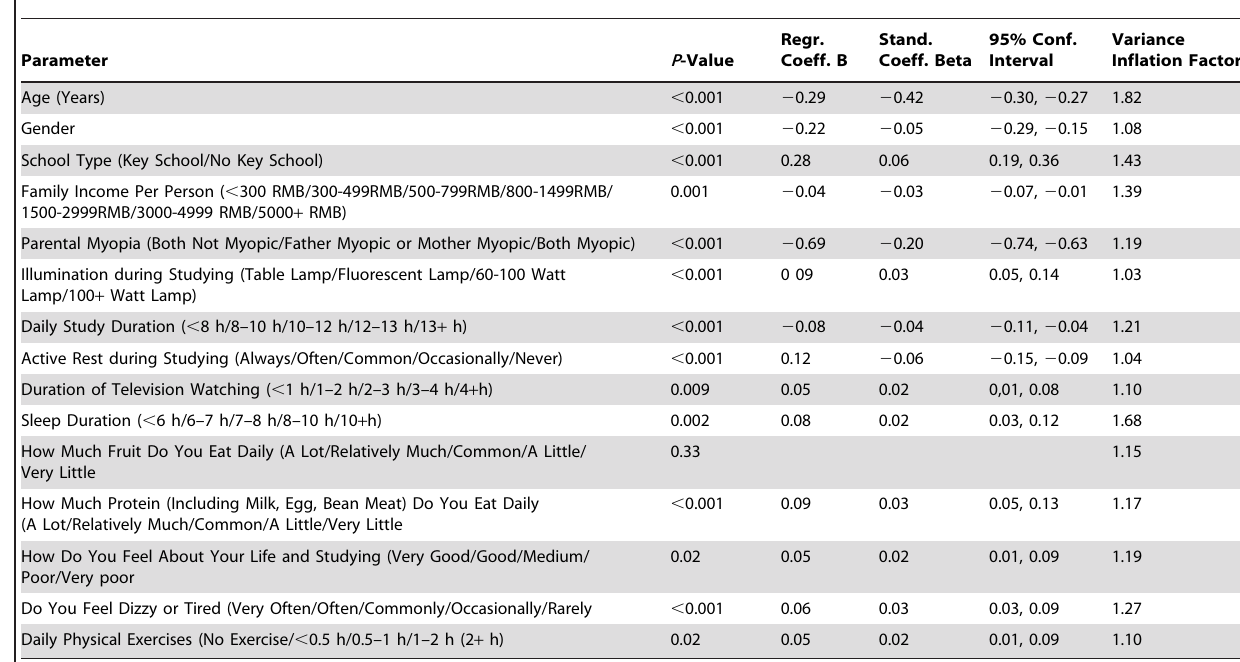
Table 4. Linear multivariate regression analysis of the associations between refractive error in the worse eye and other parameters in the Beijing Pediatric Eye